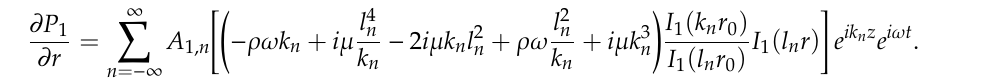
Figure 6. Distribution of normalized gauge pressure, P ∗ = Pr 0 / µ u HS , at di ff erent nondimensional times: ( a ) ω t = π /2 and ( b ) ω t = 3 π /2. All other conditions are the same as those in Figure 3.